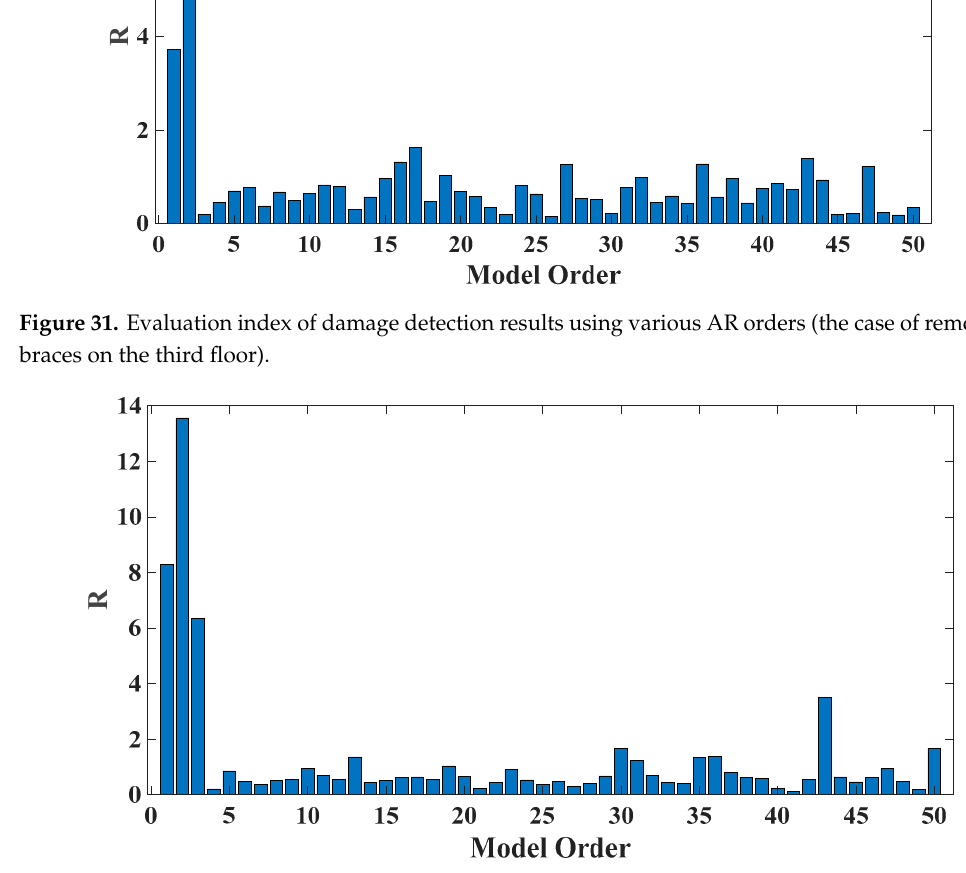
Figure 32. Evaluation index of damage detection results using various AR orders (the case of removing central columns on the third floor).